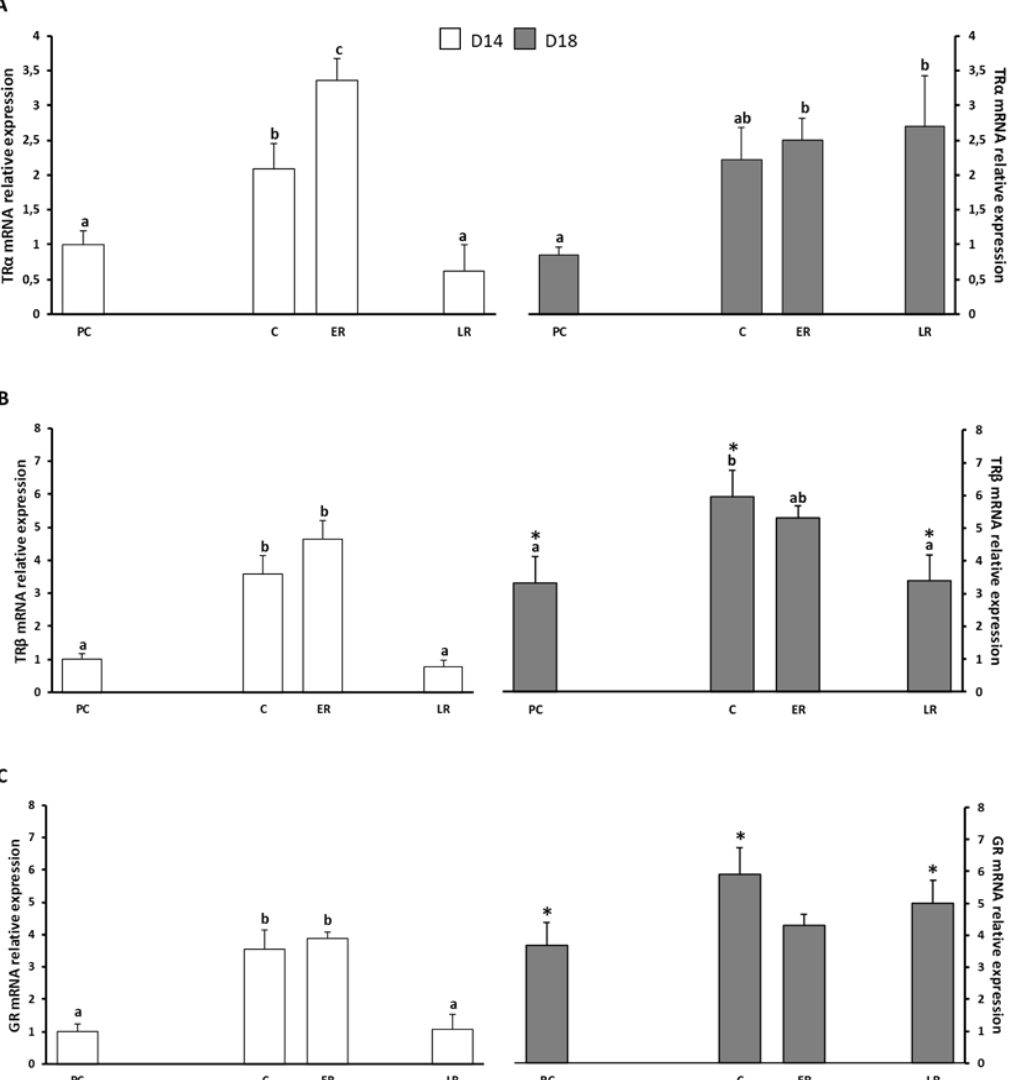
Figure 4. Relative gene expression of pituitary receptors of gilthead sea bream juveniles fed two dietary regimes during temperature fluctuations. White bars correspond to animals fed with D14 while grey to animals fed with D18 diet. Data are shown as arbitrary units referred to relative expression for D14 as Mean ± Standard error of mean. PC: Pre-Cold; C: Cold; ER: Early Recovery; LR: Late Recovery. Receptors analysed were: ( A , B ) Thyroid hormone Receptors alpha and beta, TR-alpha and TR-beta; ( C ) Glucocorticoid Receptor, GR. Lower-case letters indicate significant di ff erences between periods (one-way ANOVA); * indicate significant di ff erences between D14 and D18 (Student’s t- test).